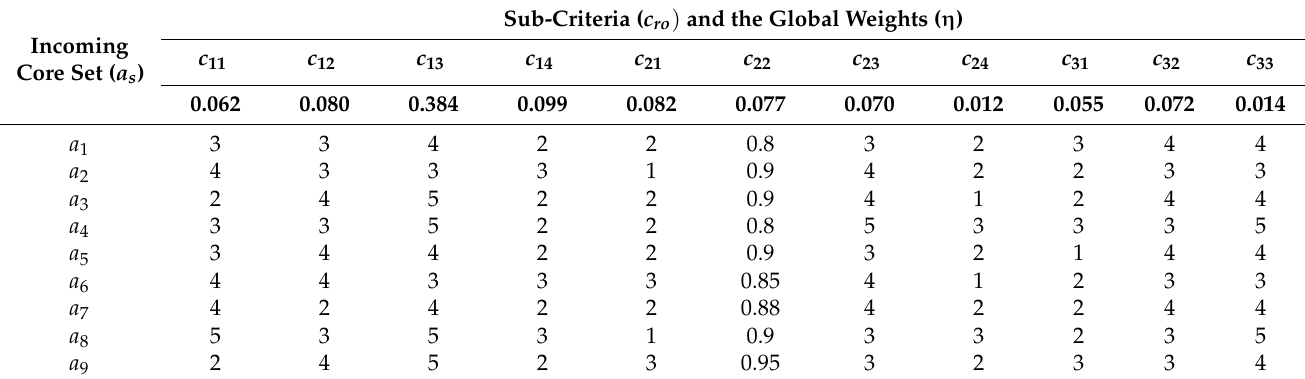
Table 11. The observed values of each criterion for each incoming core ( X sr ).